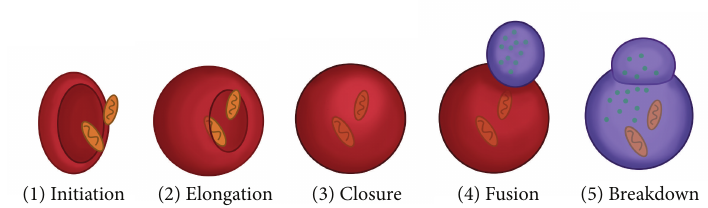
Figure 1: Steps of the autophagic pathways. Five steps in the autophagic pathways have been identified: (1) initiation, isolated membrane appears in cytosol; (2) elongation, elongation is characterized by membrane bending and an increase in the size of the phagophore; (3) closure, the autophagosome membrane wraps around the cytosolic components; (4) fusion, the fusion of the autophagosome with a lysosome to form an autolysosome; and (5) breakdown, the autolysosome is degradated by lysosomal